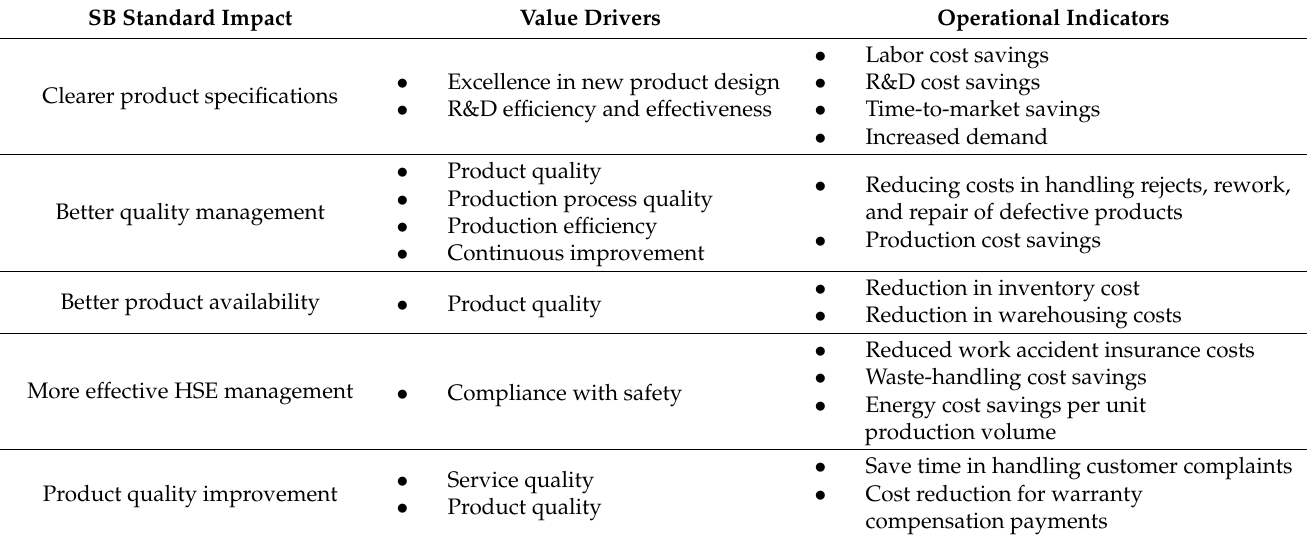
Table 8. Value drivers and operational